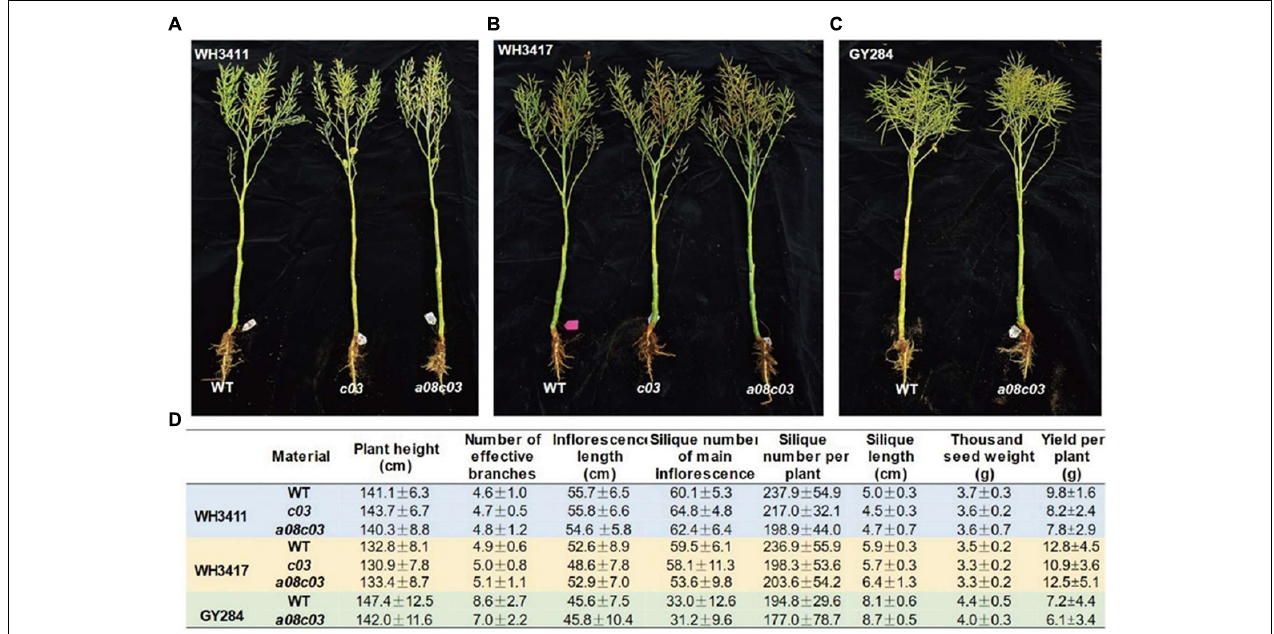
FIGURE 5 | Agronomic traits investigation. (A–C) Morphology of WH3411, WH3417, GY284, and their Bna FAE1 mutants. (D) Comparison of agronomic traits of WH3411, WH3417, GY284 with their FAE1 mutants. Values are means ± SD ( n = 6 ∼ 8).